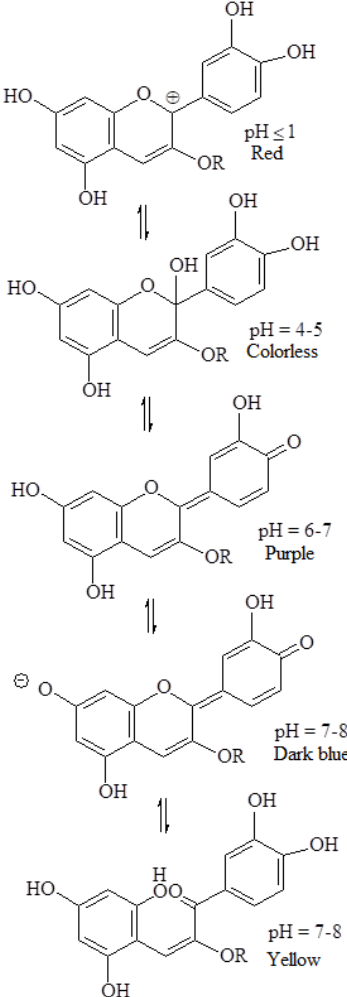
Figure 14. Example of anthocyanin changes due to pH variation [78].